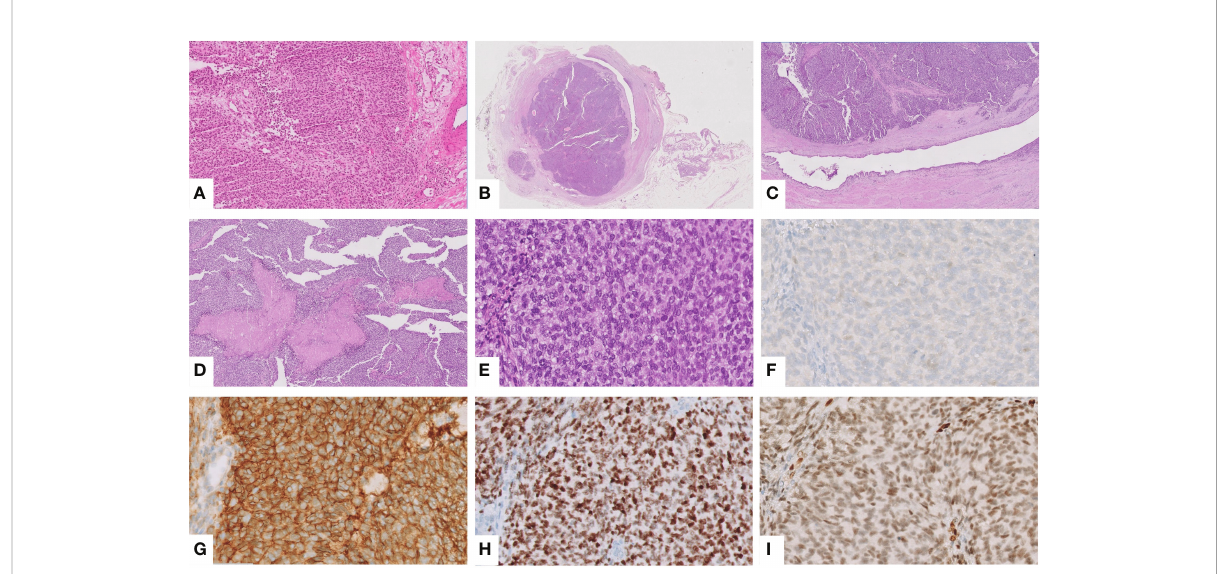
FIGURE 2 Intraoperative frozen section showing a solid proliferation of round to ovoid epithelioid cells, with atypical nuclei and eosinophilic cytoplasm, suggesting a urothelial carcinoma (hematoxylin and eosin (H&E), ×10) (A) . An obstructing mass was found in the ureteral wall (H&E, ×0.25) (B) , which corresponded to a solid growth with spared overlining urothelium (H&E, ×2) (C) and foci of necrosis (H&E, ×5) (D) . Notably, the tumor was composed of round to spindle, monotonous, small cells with the peculiar intracytoplasmic glycogen (H&E, ×40) (E) . Immunohistochemically, the tumor was negative for GATA3 (F) but showed the characteristic positivity for CD99 (G) , NKX2.2 (H) and FLI1, the suspected and most common partner of translocation, con fi rmed at NGS analysis (I) .